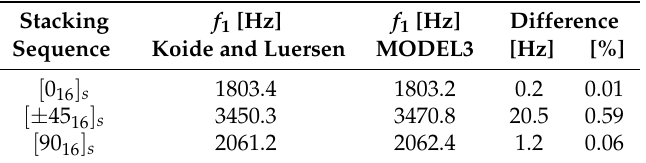
Table 1. Fundamental frequency calculated by Koide and Luersen and by using MODEL3.